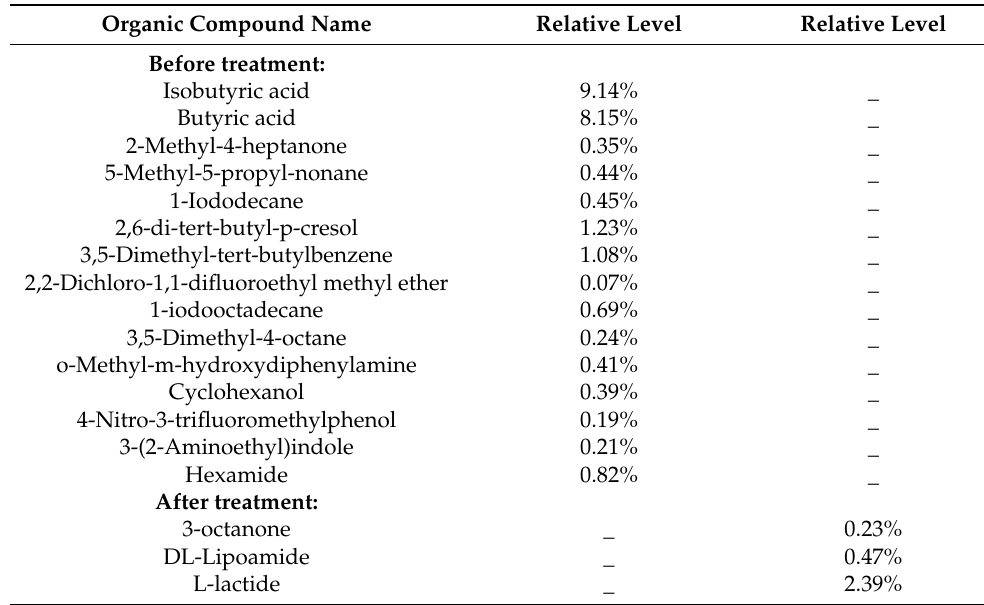
Table 2. The compositions and related levels of organic contaminants in eucalyptus CMP wastewater before and after a chlorine dioxide